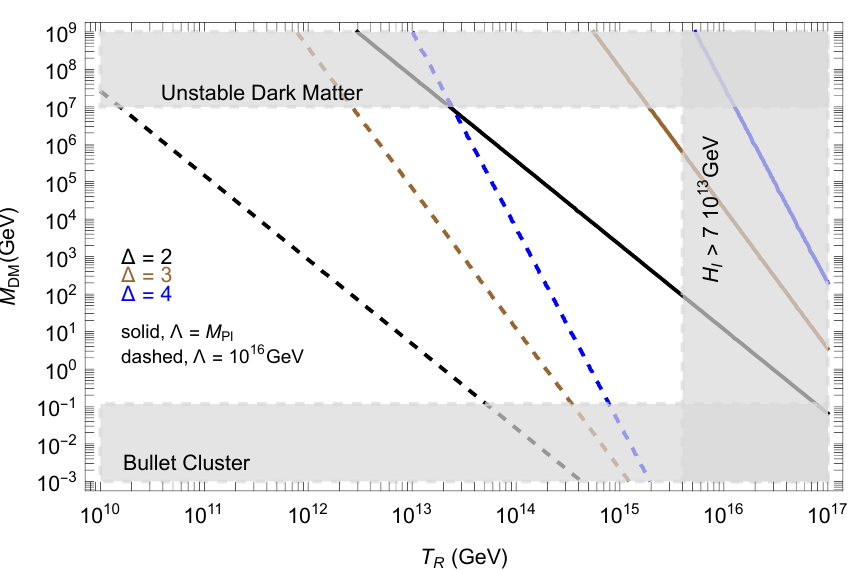
Figure 2 . Phase diagram of conformal DM produced through a Yukawa coupling for dimension 2, 3 and 4of the dark sector operators. We assume the contact interaction to be suppressed by Λ = M Pl = 2 . 4 · 10 18 GeV (solid lines) and Λ = 10 16 GeV (dashed lines), g D = 1 and M DM = 5 f . The grey regions are excluded respectively by DM self-interaction taking σ el = π/M 2 inflation and DM lifetime where we use the estimate τ DM ∼ M 4